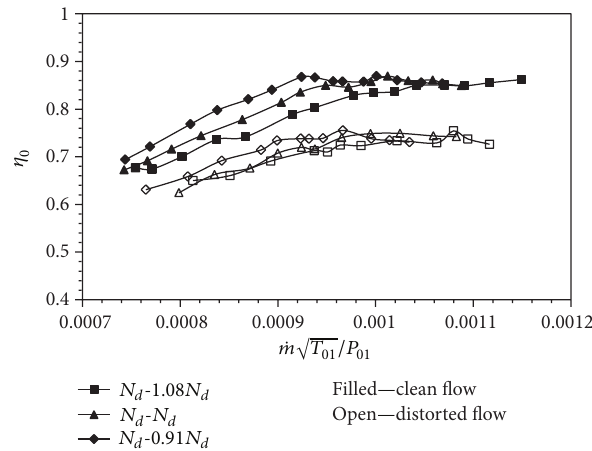
Figure 4: Variation of overall efficiency under clean and hub covered distorted flow.